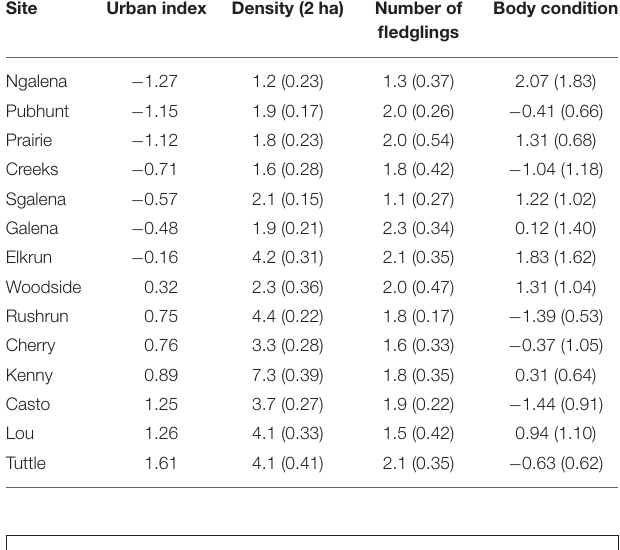
TABLE 1 | The urban index and mean (SE) for density, mean number of fledglings per year, and body condition of female cardinals distributed across 14 forested sites in central Ohio, 2004–2014. Body condition is the residual from a regression of mass against a principle component of frame size (i.e., wing and tarsus).